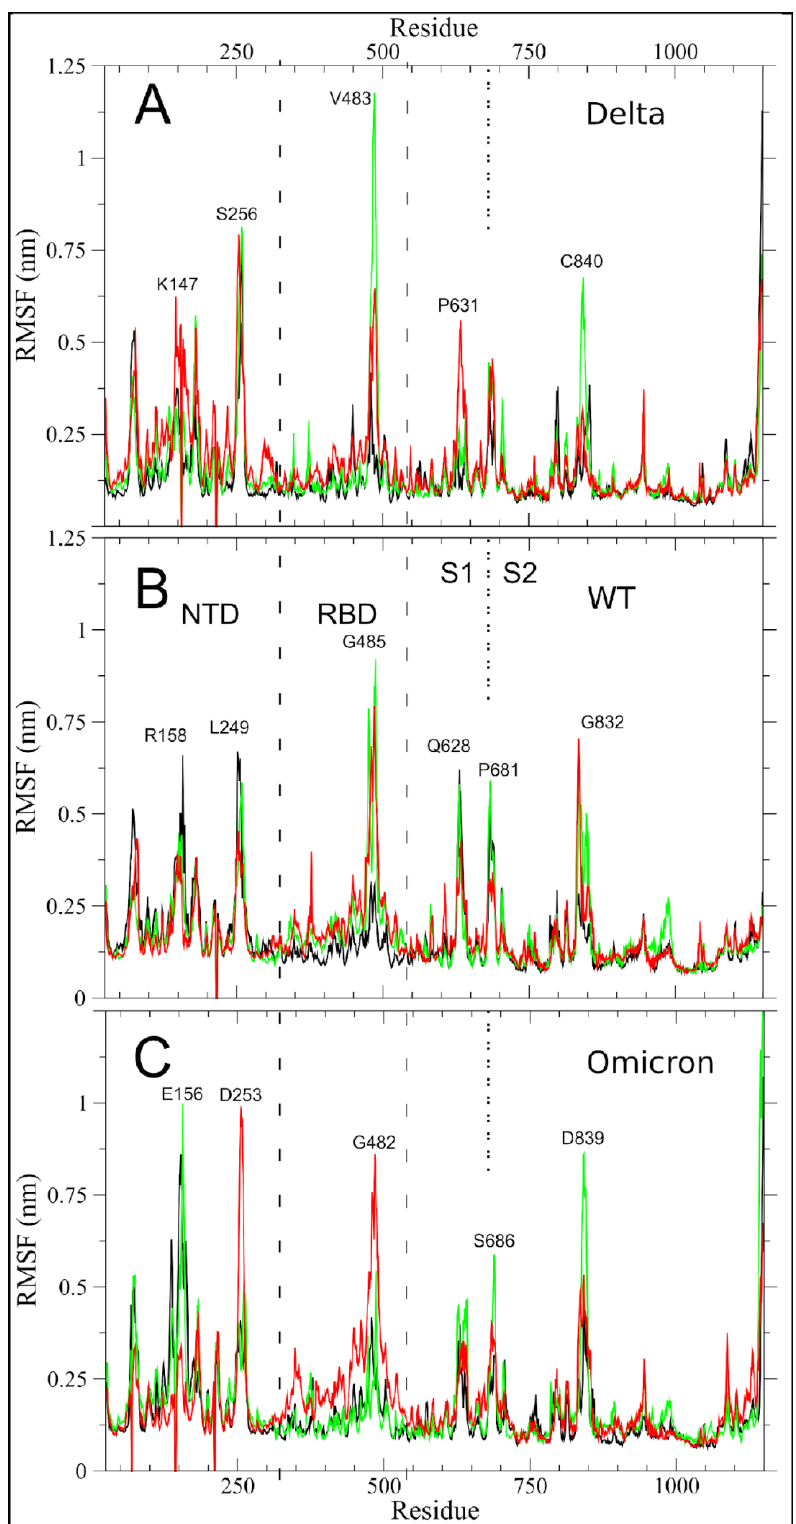
Figure 3. SARS-CoV-2 Delta, WT, and Omicron per-residue RMSF are shown in panels ( A – C ), respectively. Spike monomers 1, 2, and 3 are colored in black, red, and green, respectively. Monomer 2 differs from the others by assuming the up conformation (see M&M). The dashed lines indicate the NTD and RBD regions. The dotted line at residue 681 highlights the S1/S2 boundary. The residue numbers of fluctuation peaks are reported as in WT equivalent, not considering the deletion and insertion of